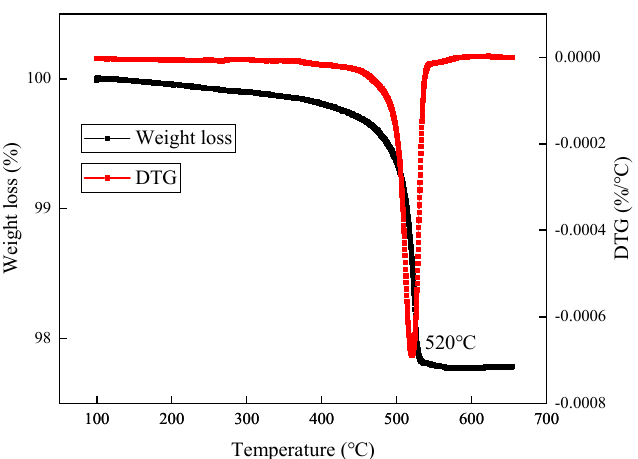
Figure 12. TG/DTG (thermo gravimetric analysis/derivative thermo gravimetric analysis) profiles of Ce 5 Zr 2 K 2 /rGO in simulated air (21% O 2 + 79% N 2 ).